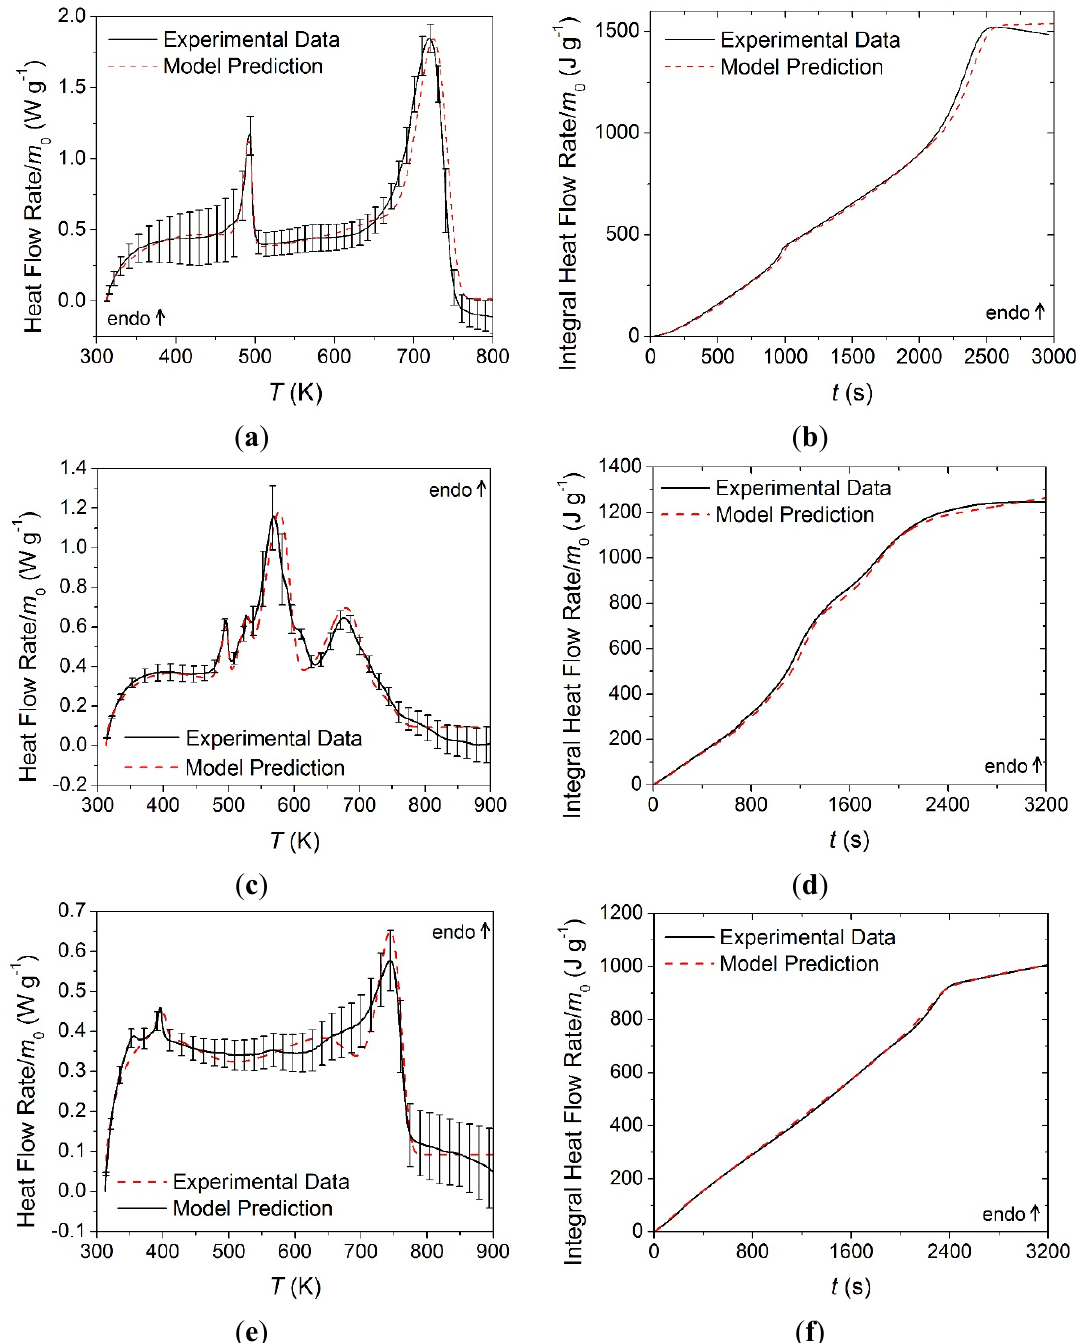
Figure 8. Normalized heat flow rate and integral heat flow rate data collected in STA experiments and model predicted curves for: ( a ) and ( b ) face yarn layer; ( c ) and ( d ) the middle layer; and ( e ) and ( f ) the base layer. Error bars indicate two standard deviations of the mean experimental data.